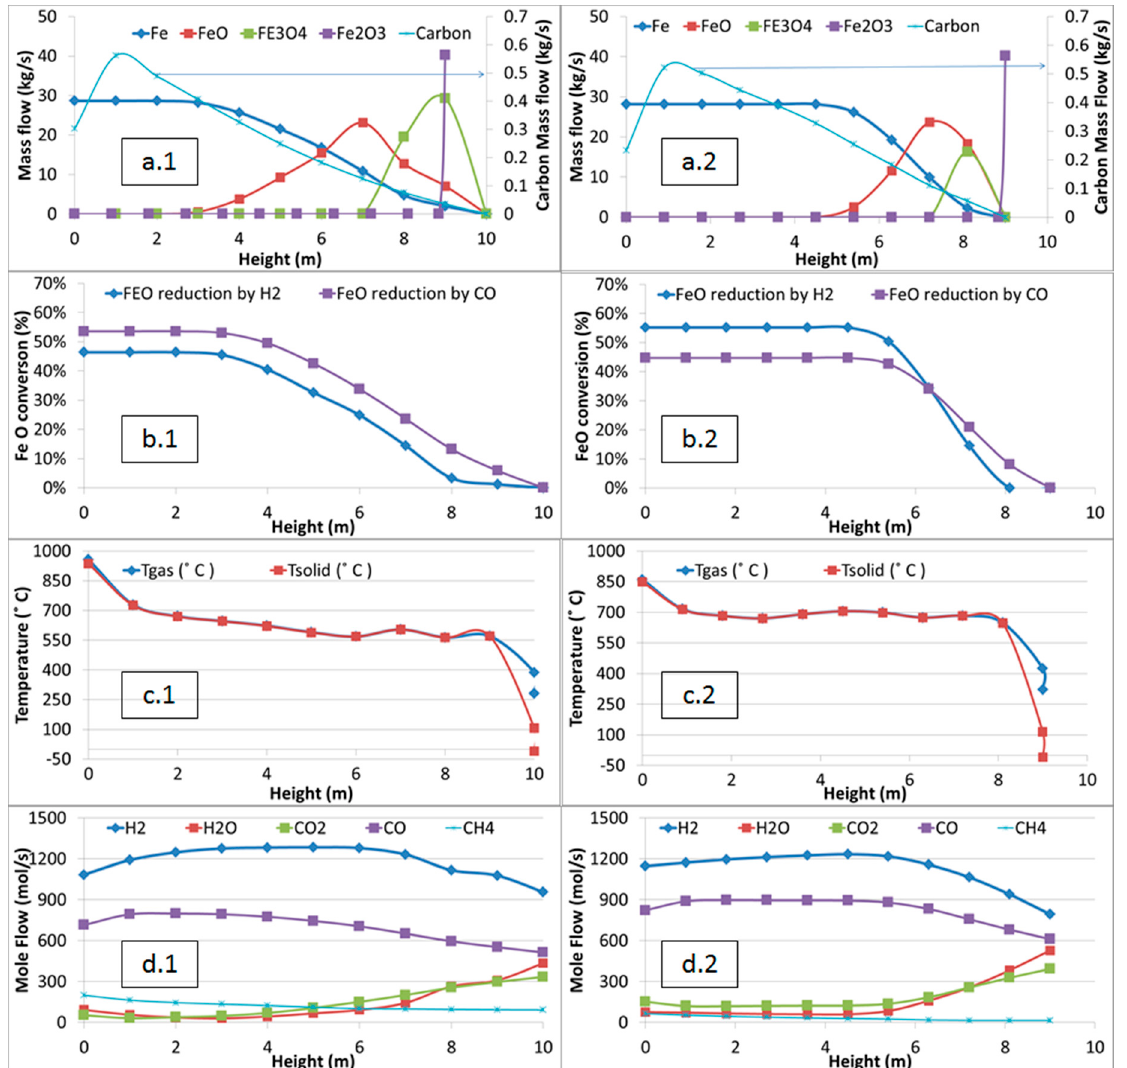
Figure 5. Evolution of the solid mass flow rates ( a ), FeO conversion from H 2 and CO ( b ), temperatures ( c ) and gas molar flow rates ( d ) along Zone 1 height for the reference (left column .1) and optimized (right column .2) plant operation.